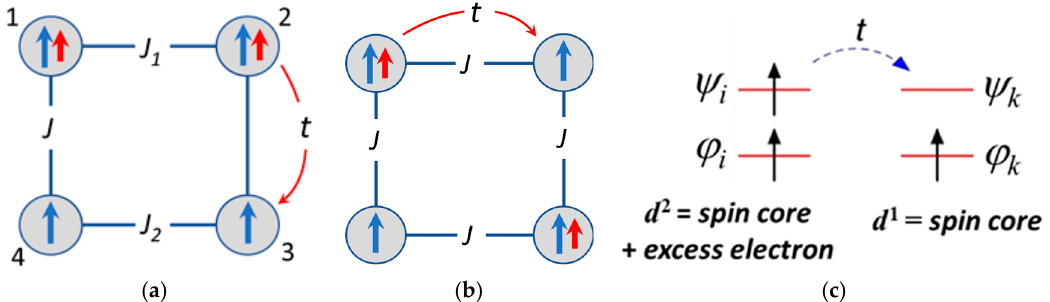
Figure 2. Schemes of the magnetic sites, exchange and transfer parameters for the tetrameric MV cluster with two mobile electrons shown for the neighboring Coulomb configuration D 3 ( a ) and for distant configuration D 1 ( b ), and also the orbital scheme of the one electron transfer between the two sites i and k shown for the simplest case of one-electron spin cores. φ are the orbitals occupied by the localized electrons (spin-core orbitals), and ψ are the upper orbitals available for the transfer of the excess electron ( c ).